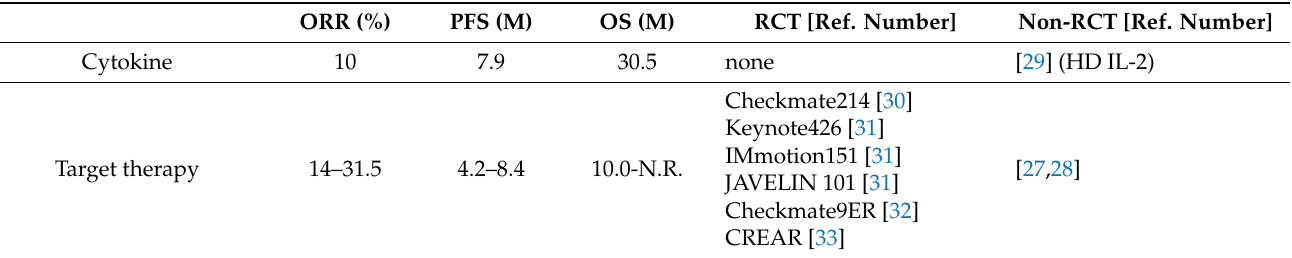
Table 2. Summary of efficacy in patients with sarcomatoid